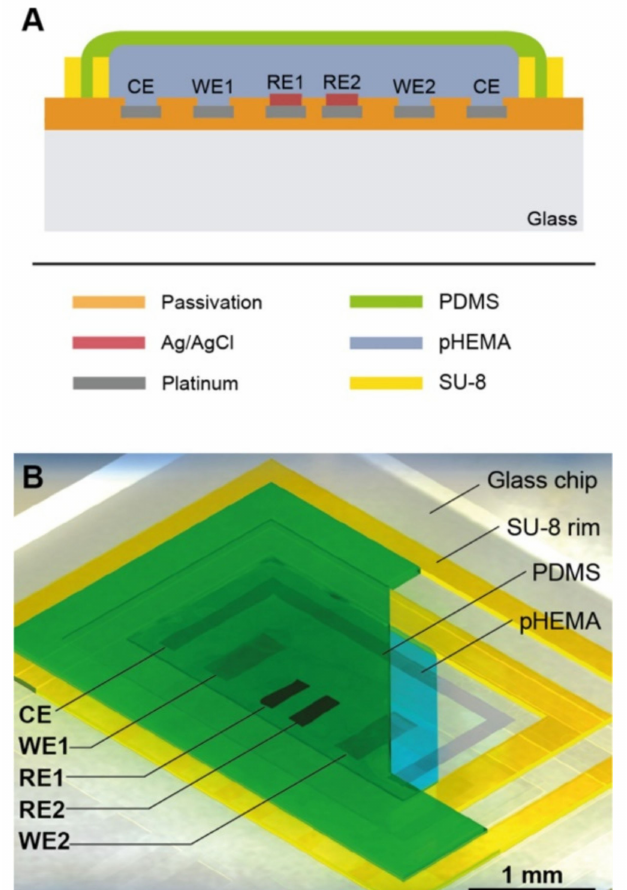
Figure 5. Clark-type microsensor, reproduced with permission from Ref. [137]. ( A ) A graphic show- ing the sensor (not to scale) including a pHEMA-hydrogel with PBS electrolyte that is surrounded by a gas-permeable PDMS membrane. Additionally, a counter electrode surrounds two Ag/AgCL reference electrodes (RE1, RE2) and two working electrodes (WE1, WE2). The purpose of the SU-8 ring is to define the hydrogel area and create a union of the PDMS membrane. ( B ) Graphic showing the Clark-type